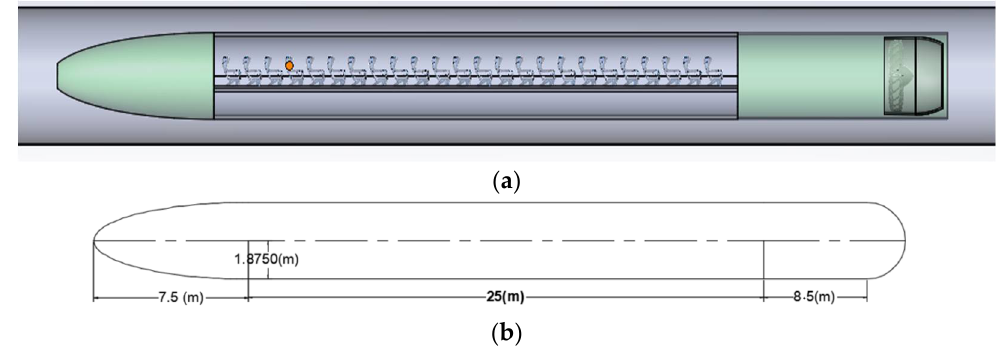
Figure 1. ( a ) Pod and cabin detailed views; ( b ) simplified 2-D pod configurations.